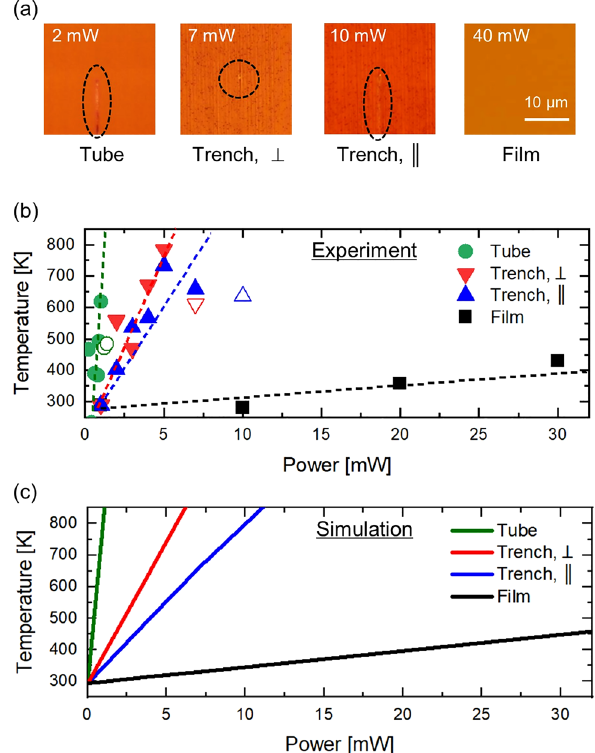
Figure 3: (a) Optical microscope images of the four samples. For tube, trench ( ⊥ ), and trench ( || ), the damages are visible when the incident laser powers after the objective lens were 2, 7, and 10 mW, respectively. For fi lm, there was no damage even at 40 mW. Power- dependent surface temperature (b) extracted from Raman spec- troscopy measurements and (c) numerical simulations based on fi nite element method. In panel (b), fi lled mark (un fi lled mark) in- dicates that the irradiated position was not damaged (damaged) at thelaserpower.Thedashedlines,whichexcludetheun fi lledmarks, are for the convenienceto follow the trend. The reason for excluding the un fi lled marks is that the extracted temperatures with damages underestimate the